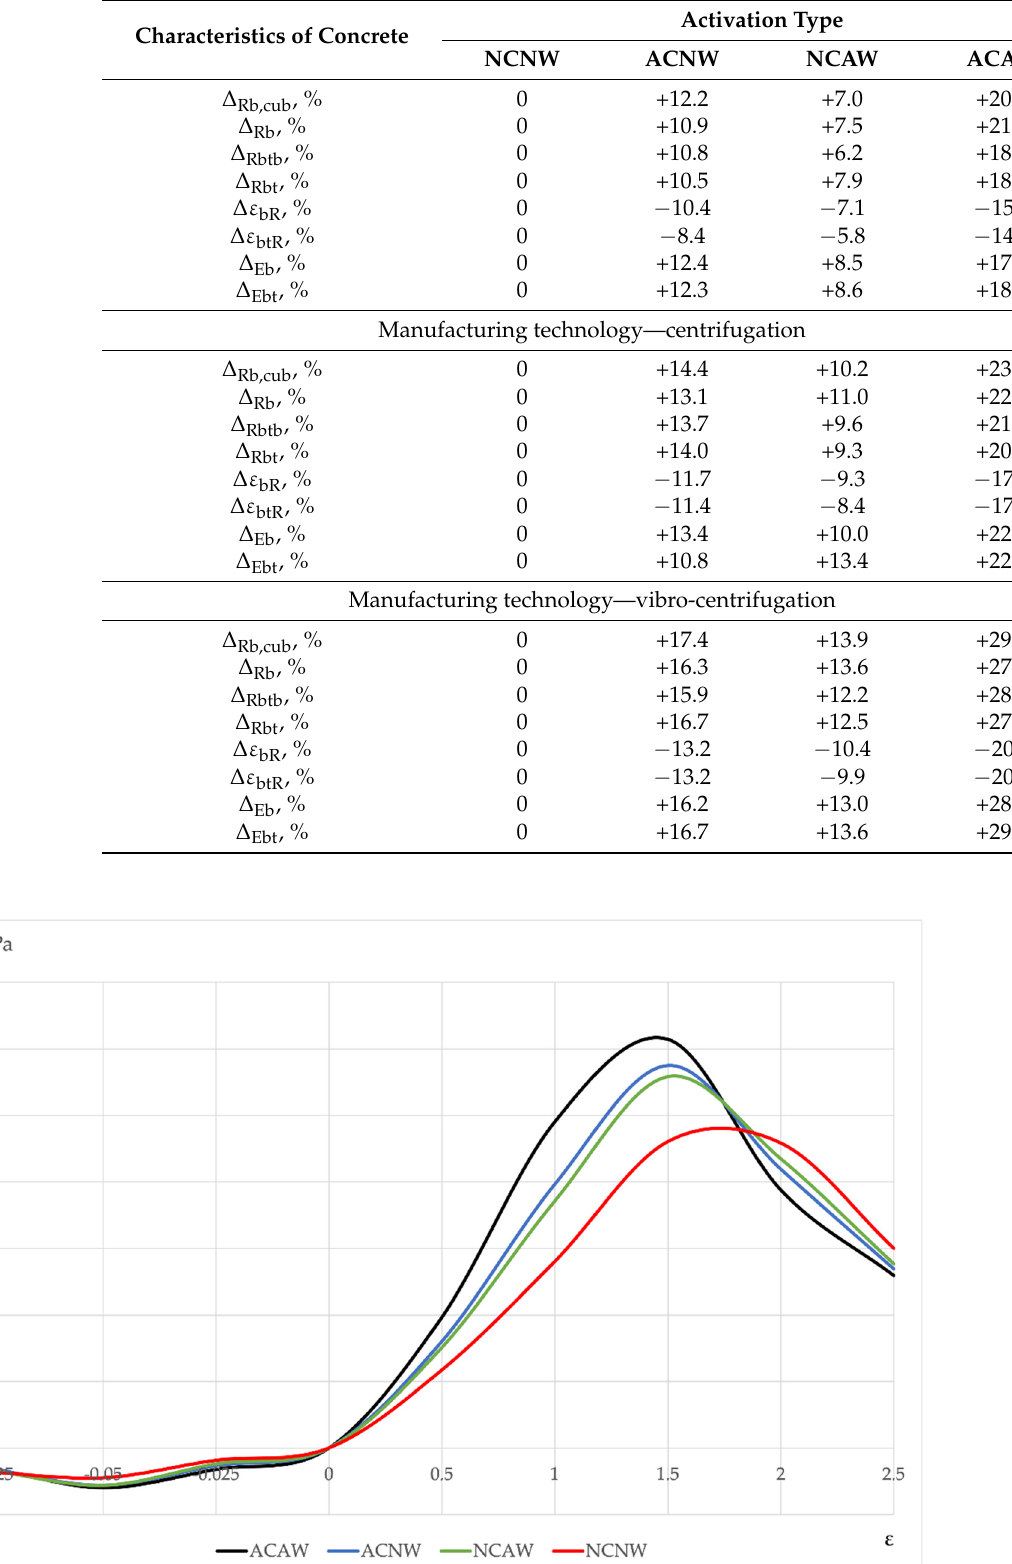
Figure 14. Influence of the type of activation on the strain diagrams of vibro-centrifuged concrete. In all cases, under compression and tension, vibro-centrifuged concretes had the highest peak shifted up and to the left (or down and to the right for stretching) relative to the peak of the diagram of centrifuged concretes, and even more so relatively vibrated ones. This is due to the greater strength of vibro-centrifuged concretes relative to other types. The same picture was observed for the diagrams of vibro-centrifuged concretes obtained with different types of activation. The highest strength concrete, ACAW, had the highest peak shifted to the left (down and right to stretch). The tendency for the peak to